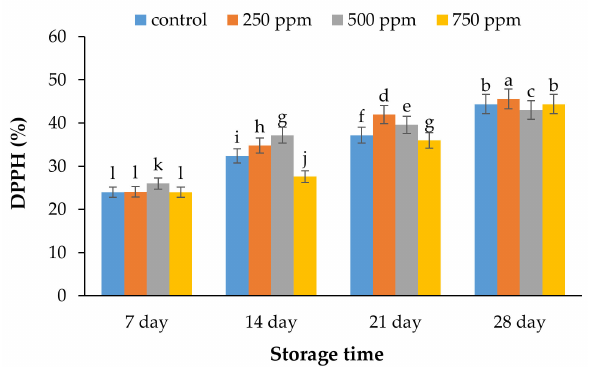
Figure 3. Effect of ACEOs on the antioxidant activity of strawberries during storage. Different letters indicate a significant difference ( p < 0.01) between